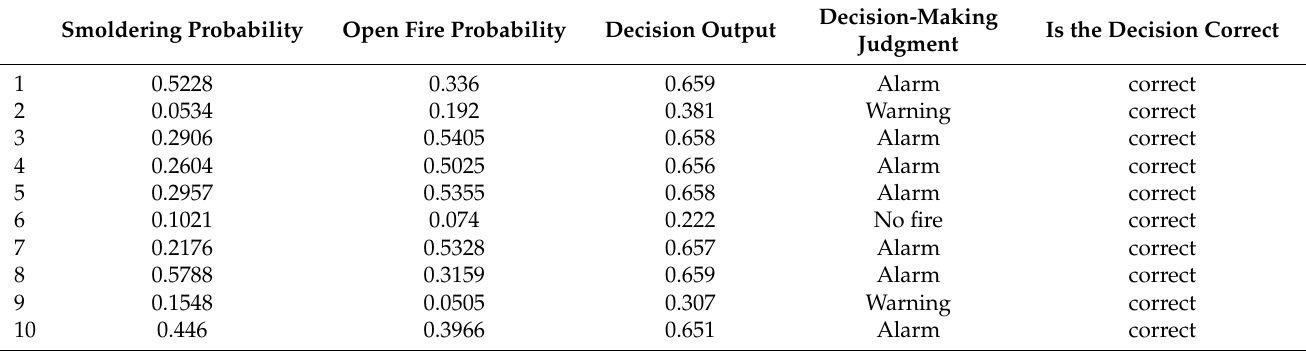
Table 1. Decision-making judgment of fire probability value of forecast